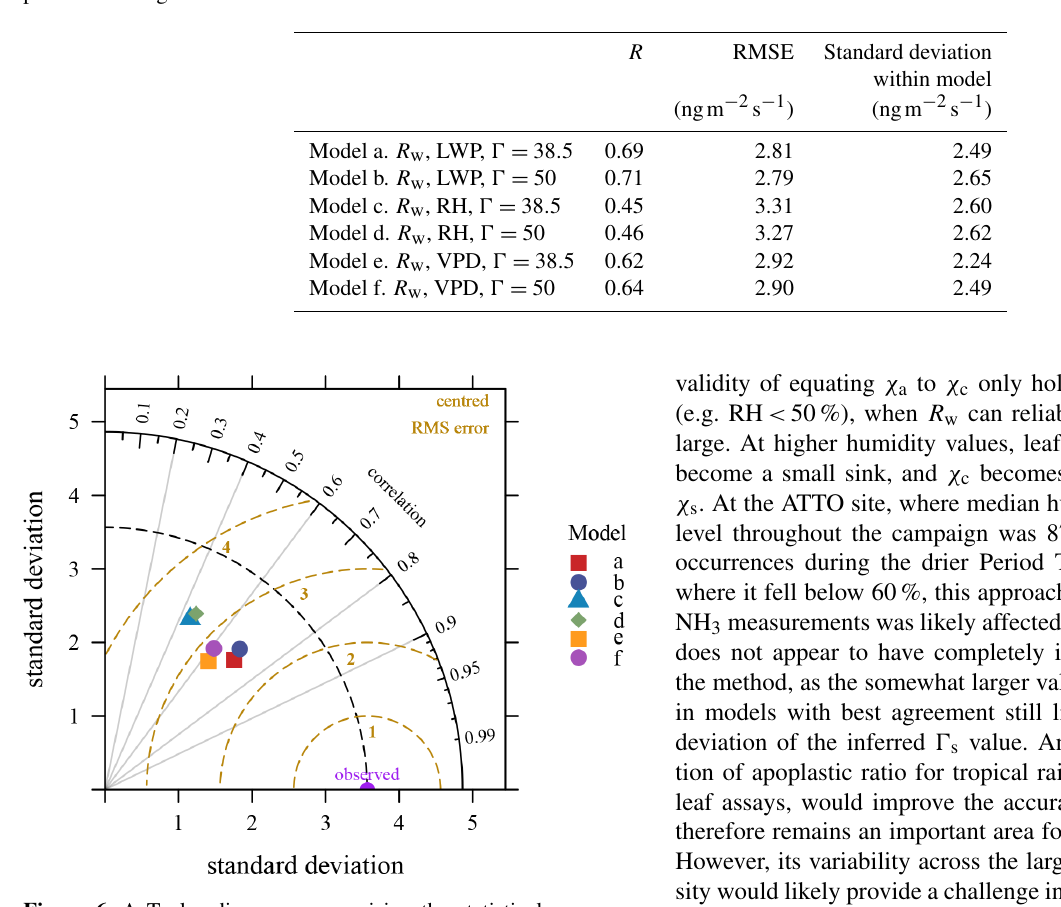
Table 2. Summary of model statistical performance (correlation coefficient R , centred root mean square error, and standard deviation) as presented in Fig. 6.